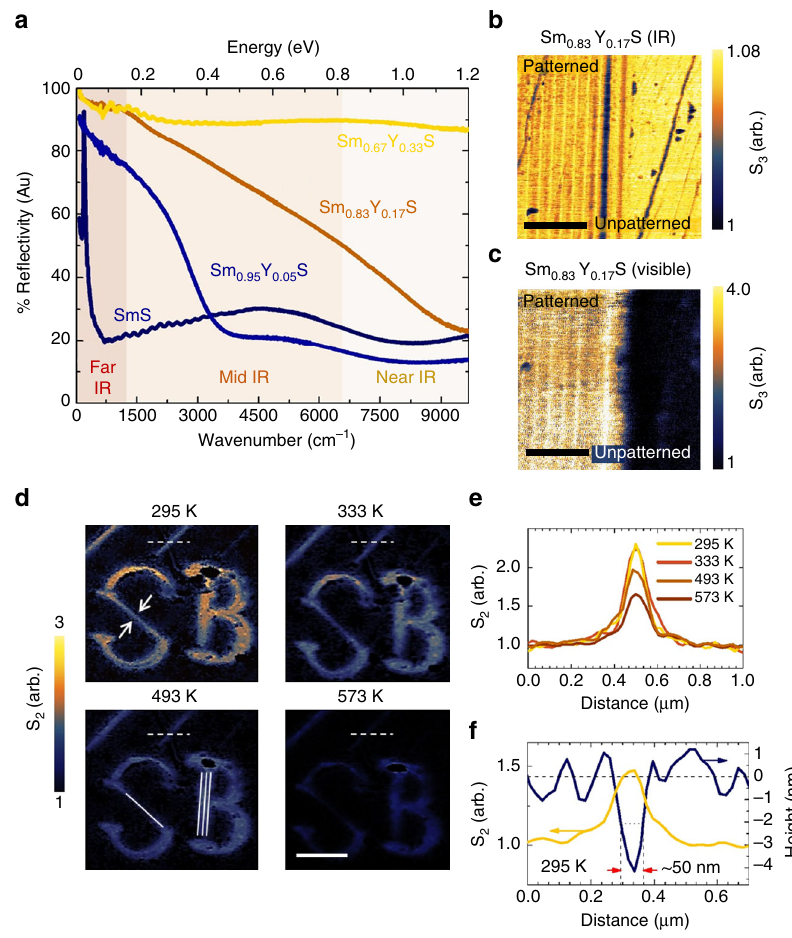
Fig. 4 Dopant and temperature tuning of the near- fi eld re fl ectivity. a Far- fi eld re fl ectivity plot of Sm 1 − x Y x S for x = 0, 0.05, 0.17, and 0.33. b , c Near- fi eld imaging of a grating pattern on the surface of a Sm 0.83 Y 0.17 S sample collected at 113 meV and 1.68 eV, respectively. The scale bars in both images are 1 μ m. d Near- fi eld imaging at 117 meV of micro-letters “ SB ” (Stony Brook) patterned on the surface of undoped SmS at room temperature subsequent to heat treatment at 333, 493, and 573 K. The solid white lines in the 493 K image indicate the number of lithographic lines required to produce the pattern in given areas. The scale bar is 1 μ m. e A direct comparison of the near- fi eld amplitude line pro fi les indicated by dashed white lines in d , is shown, highlighting the ability to tune the strength of the local IR re fl ectivity with temperature. f Height pro fi le (blue line) and normalized near- fi eld amplitude (gold line) of a lithographically patterned line (indicated by white arrows) at the center of the lithographic “ S ” in d . The FWHM is ~50 a 20 × 20 lithographic grid with line spacing of 1 μ m and a total area of ~40 × 40 μ m, while the grating MM is 10 parallel lines spaced 1 μ m apart with a total area of ~12 × 12 μ m. Area-averaged